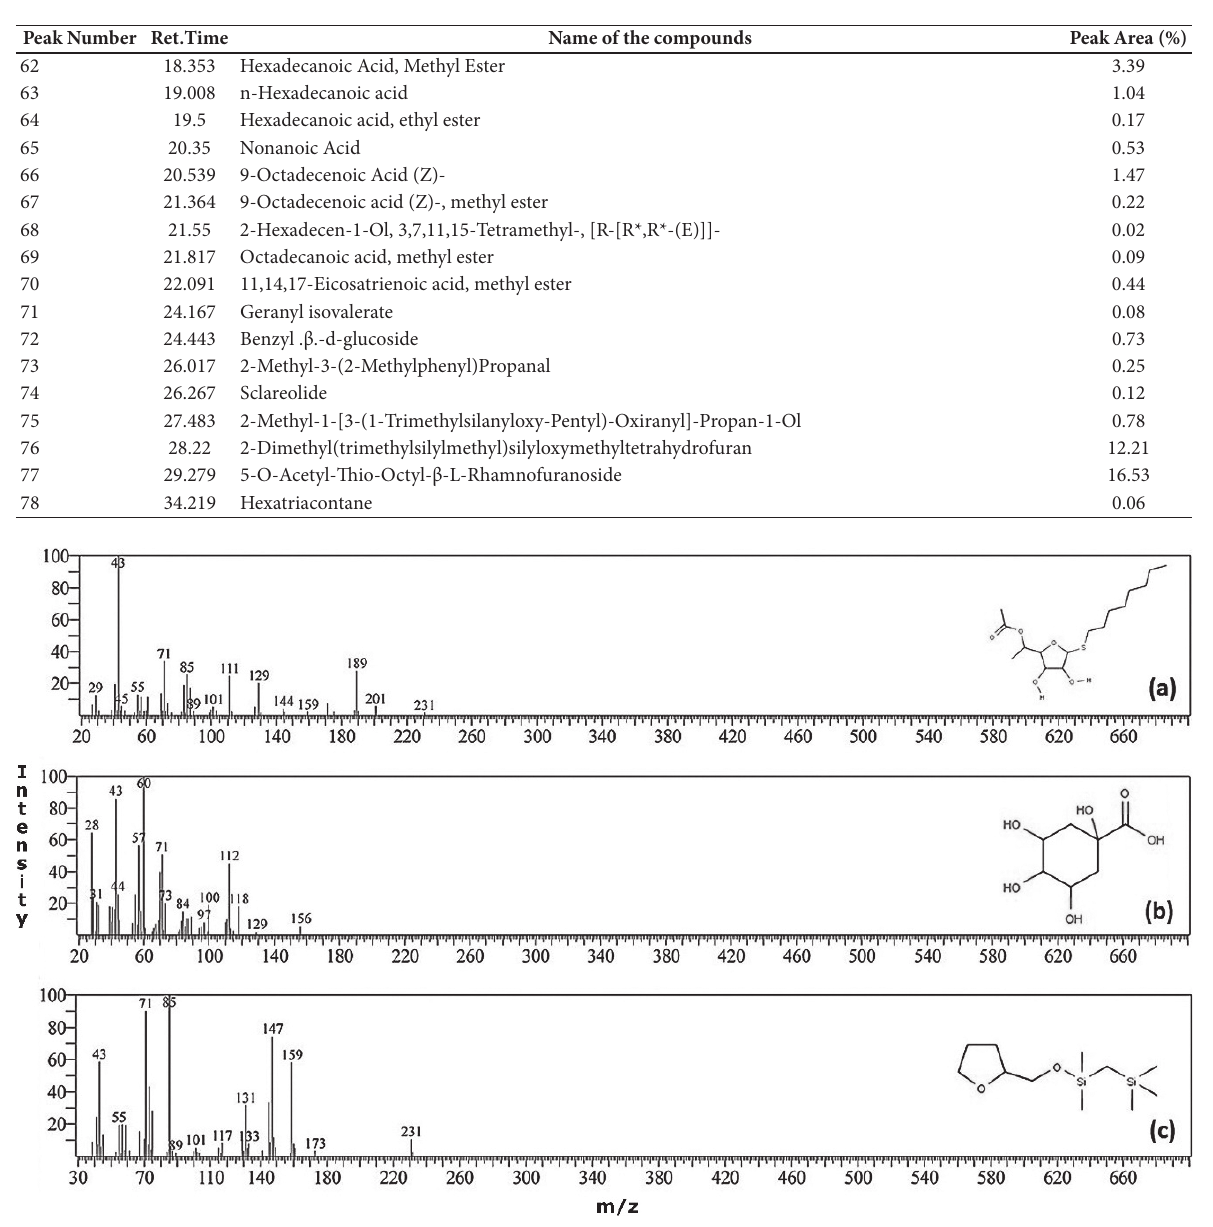
Figure 6. Mass spectrum and structure of main compounds identified by GCMS in the methanol extract of M. oleifera : (a) 5-O-ace- tyl-thio-octyl-β-L-rhamnofuranoside; (b) Quinic acid; (c) 2-Dimethyl(trimethylsilylmethyl)silyloxymethyltetrahydrofuran. Table 3. The inhibition value of methanol extract of M. oleifera leaves against